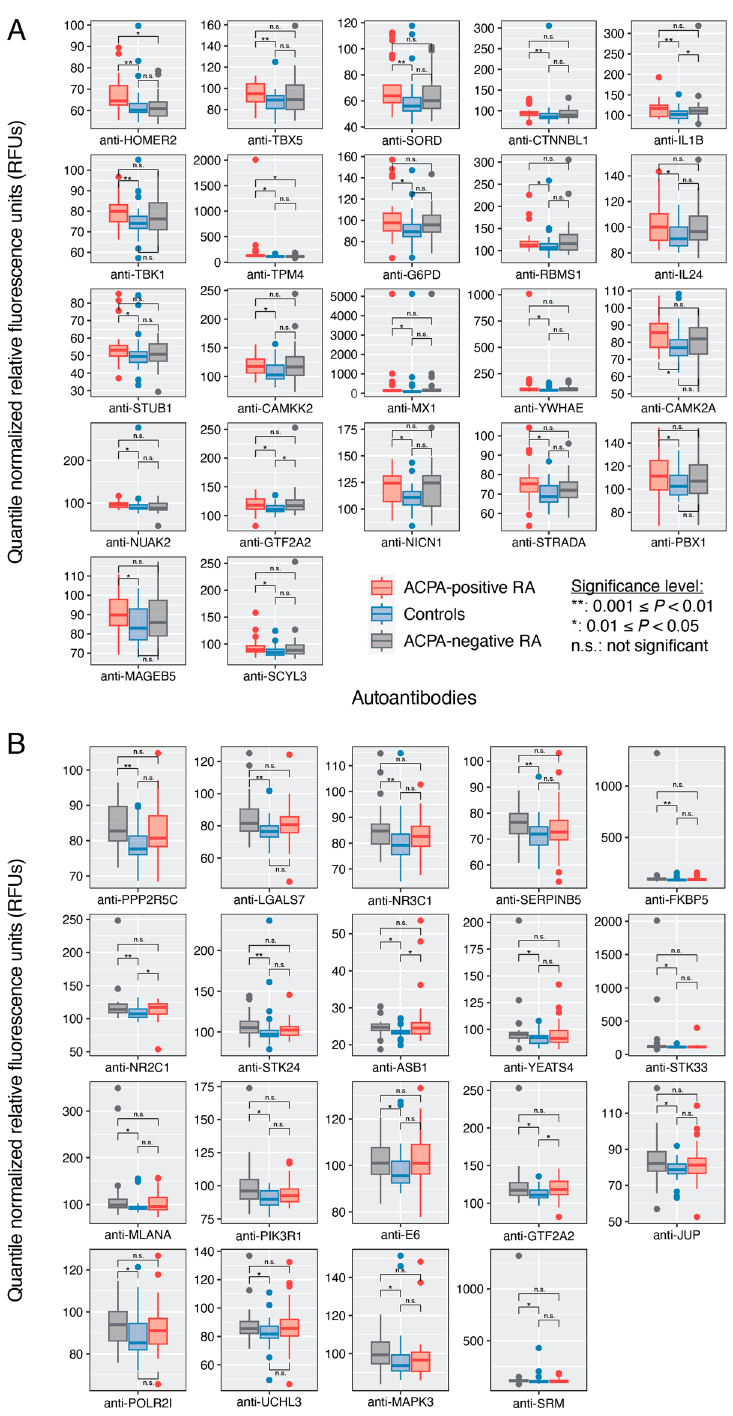
Figure 2. Serum autoantibodies with higher abundances in ACPA+ RA and ACPA− RA compared with healthy controls. Patients with ( A ) ACPA+ RA ( n = 32) and ( B ) ACPA− RA ( n = 30) show higher abundances in 22 and 19 autoantibodies, respectively, compared with healthy controls ( n = 30). In ( A ) and ( B ), the other RA subgroup is shown for comparison (far right). Two-sided Mann–Whitney U test ( P < 0.05) and the Cliff’s delta effect size (| d |> 0.33) were used to find autoantibodies with significantly higher abundances. Standard box-and-whisker plots (e.g., center line, median; box limits, upper and lower quartiles; whiskers, 1.5 × interquartile range; points, outliers) are used to show autoantibody abundances. Anti-GTF2A2 was found to have a significantly higher abundance in both ACPA+ RA and ACPA− RA